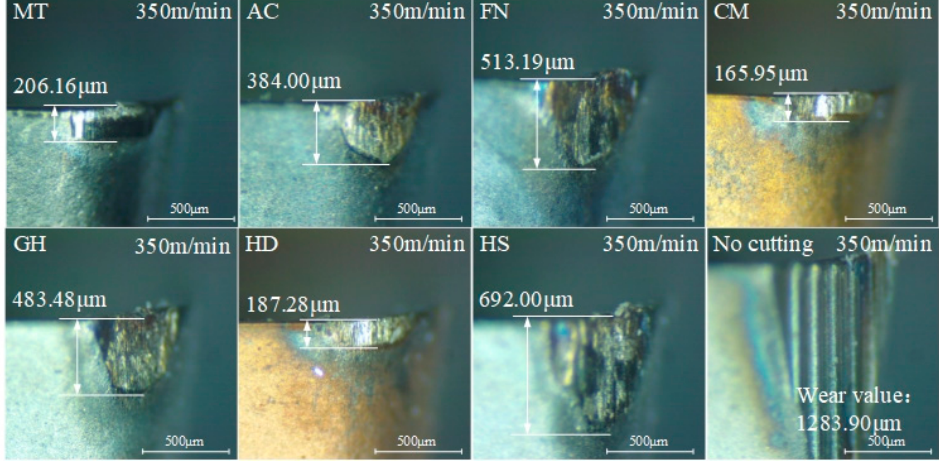
Figure 17. Tool flank wear of different coatings at high speed. Figure 18. Tool flank wear of different coatings after cutting 1000 m at high speed.